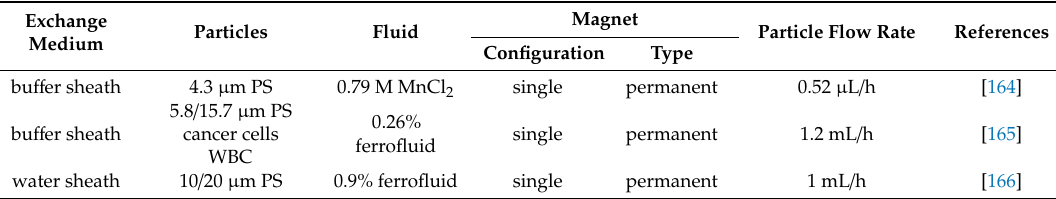
Table 5. Summary of the published papers on diamagnetic particle medium exchange in magnetic fluid